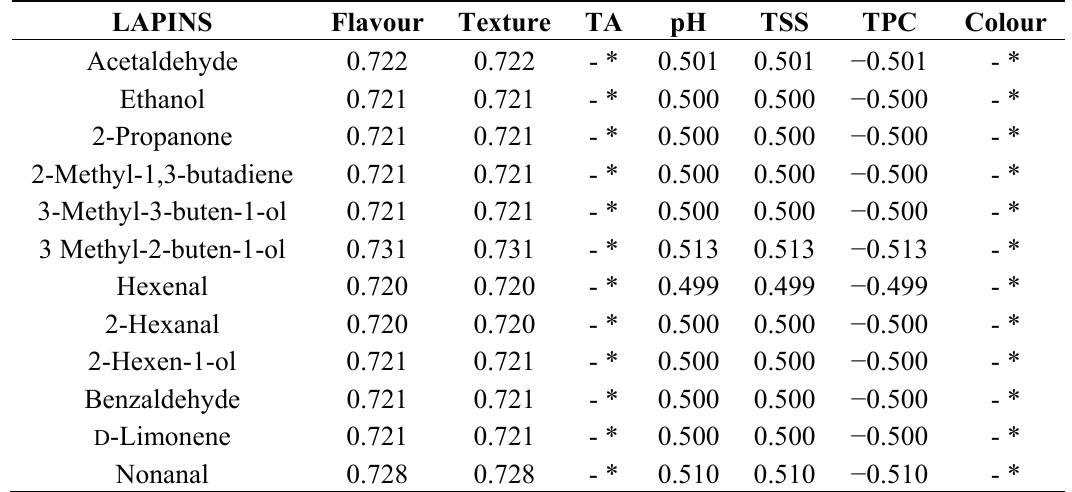
Table 6. Correlation between volatile compounds and physicochemical/sensory attributes in the Lapins cultivar.